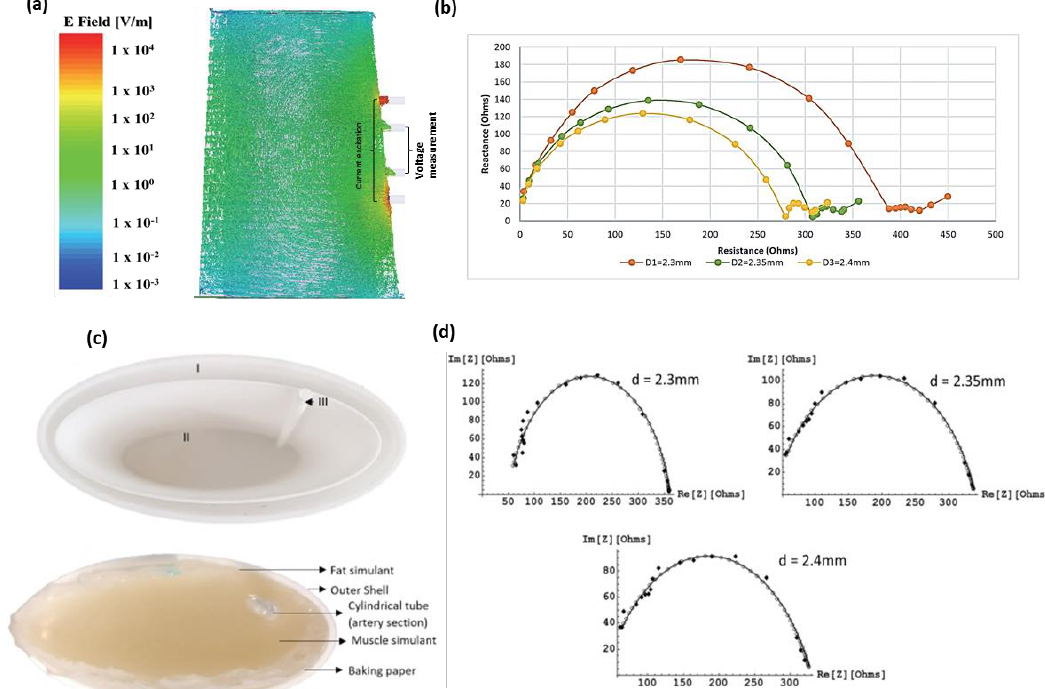
Figure 1. Summary of the results from our preliminary studies. ( a ) Electric field distribution from the simulation study at 50 kHz. ( b ) Simulation-obtained Cole plots for impedance spectra at three different diameters. ( c ) Preparation of the forearm phantom (I—Fat, II—Muscle and III—Artery). ( d ) Comparison of the simulation and phantom results with the same material properties.